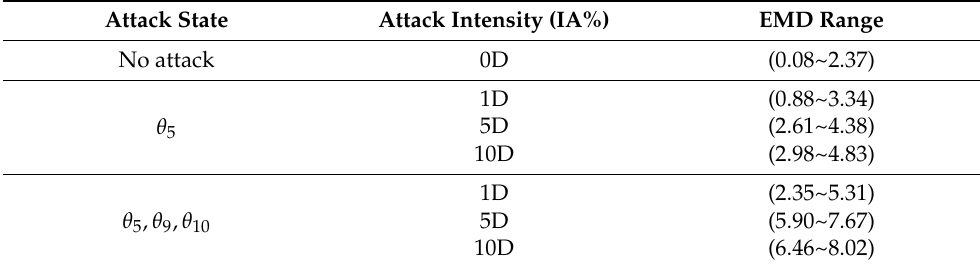
Table 1. Consider the range of EMD under different attack